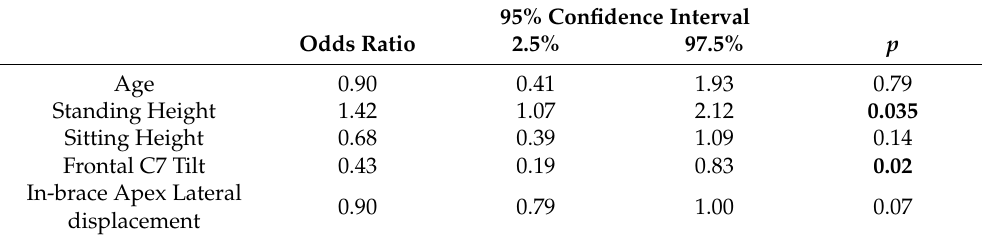
Table 7. Main lumbar multivariate analysis. Bold indicates p < 0.05